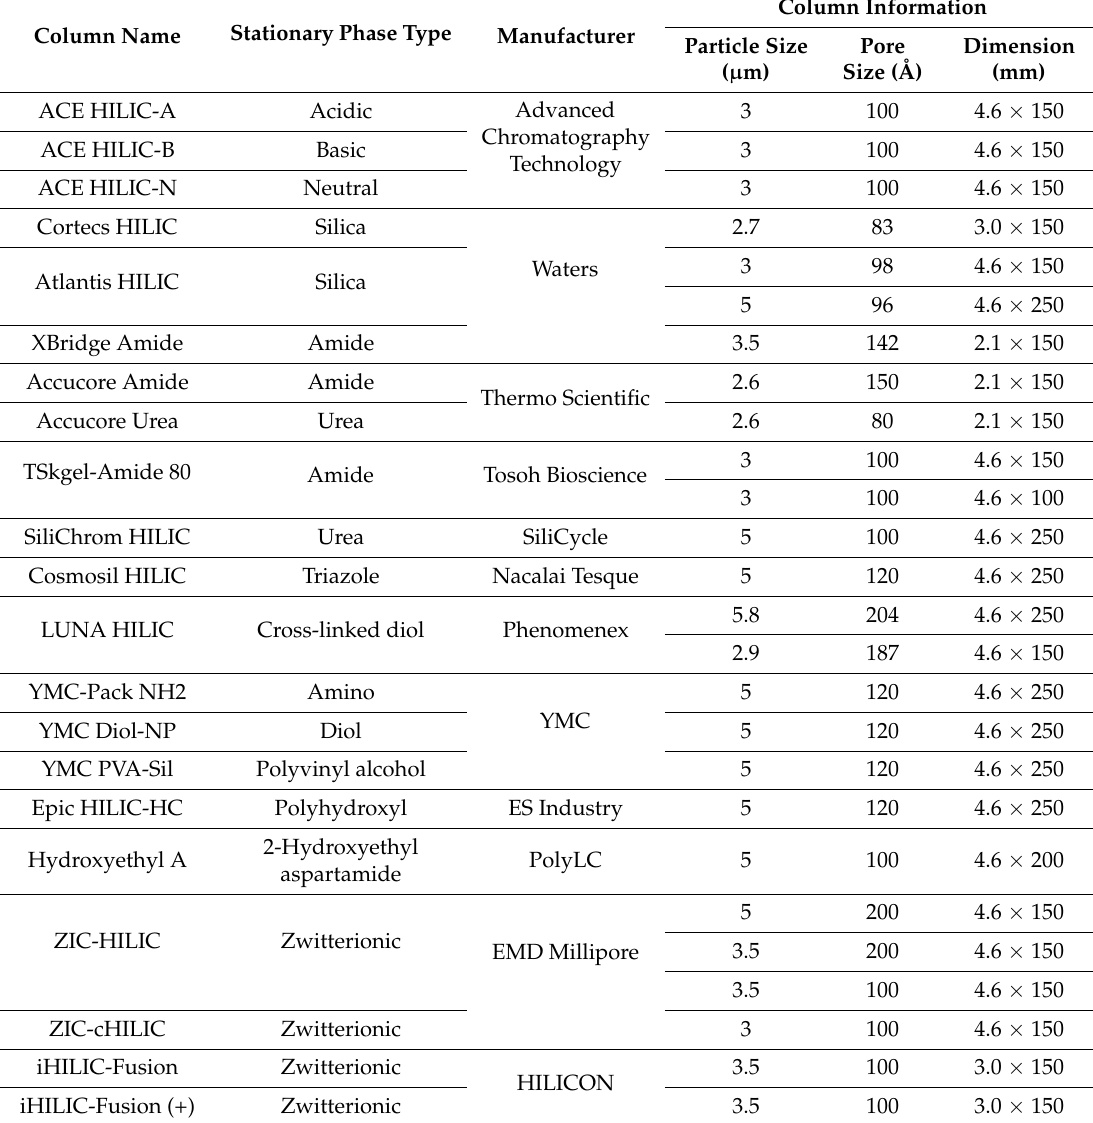
Table 1. Detailed Information of the polar stationary